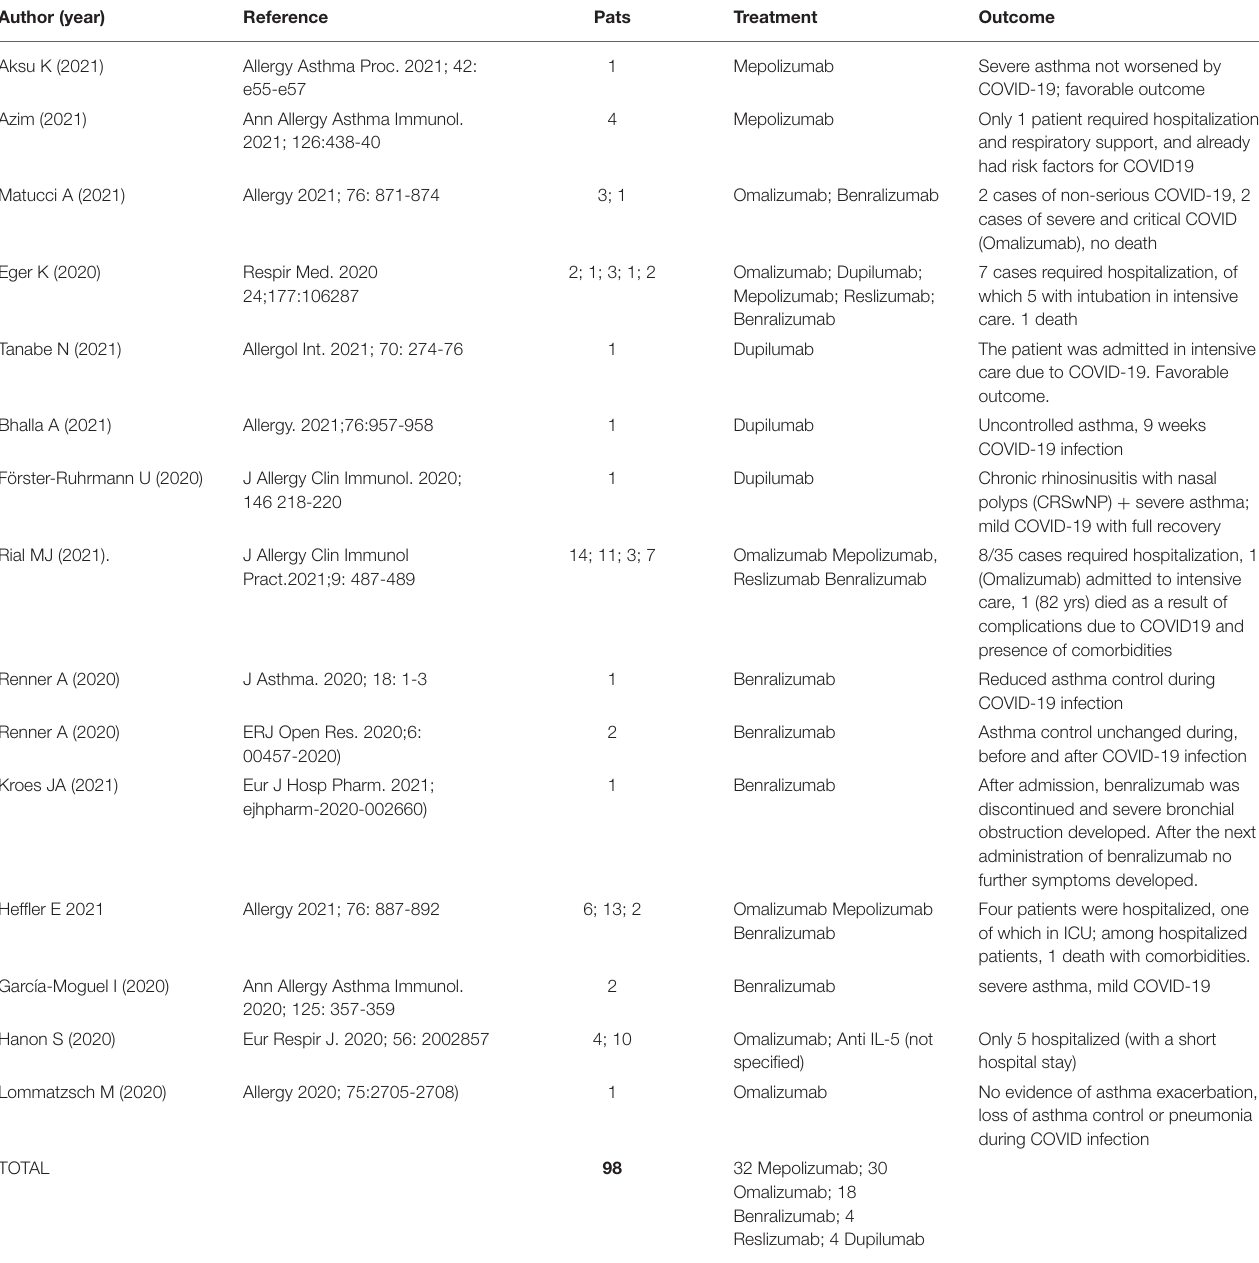
TABLE 1 | Reports on patients receiving biologicals and having